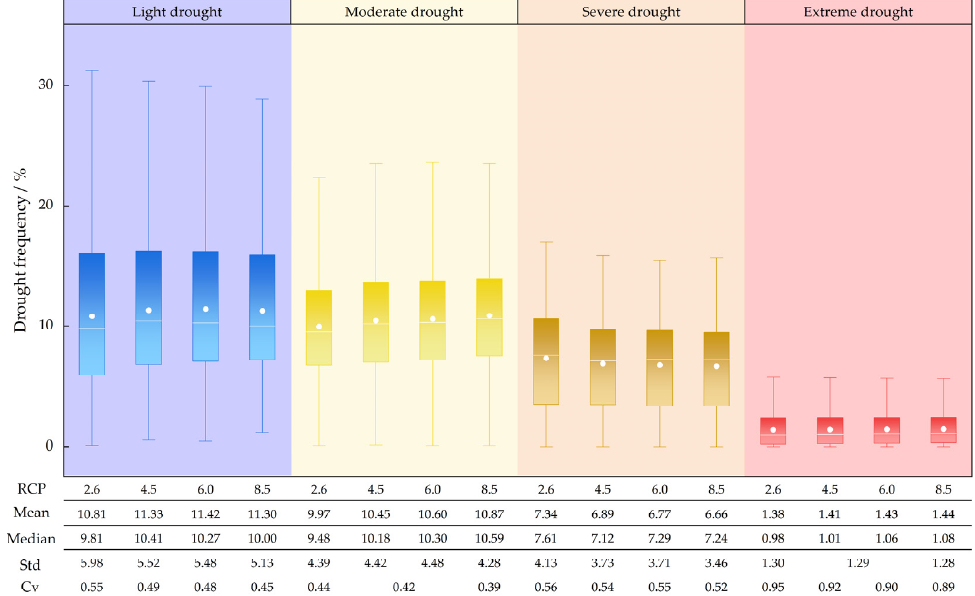
Figure 10. Predicted drought frequencies for various categories at each grid point on the TP from 2016 to 2099 under four climatic scenarios.